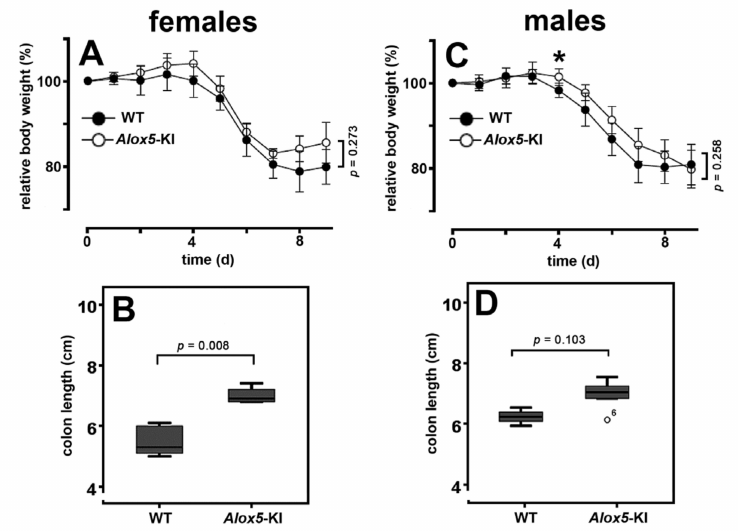
Figure 6. Comparison of Alox5 -KI mice and wildtype controls in the DSS colitis model. Alox5 -KI mice (5 males, 5 females) and outbred wildtype controls (5 males, 5 females) were taken through